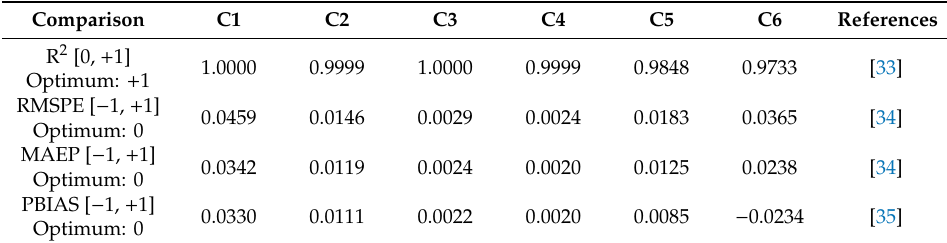
Table 1. Metrics of the comparisons proposed.